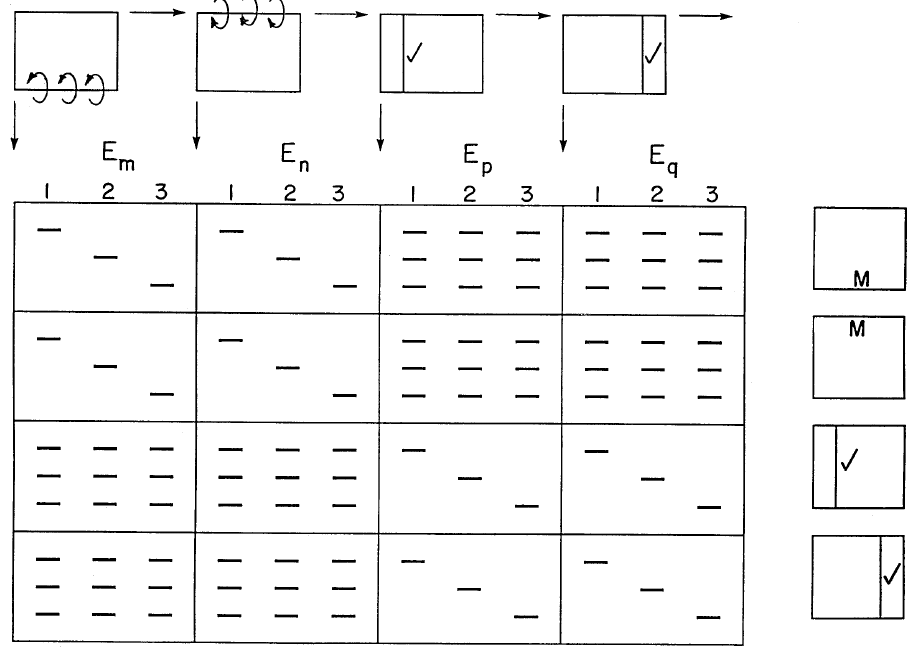
Fig. 4. Schematic representation of the eigenvalue matrix required for analyzing 3-span brudge deck.